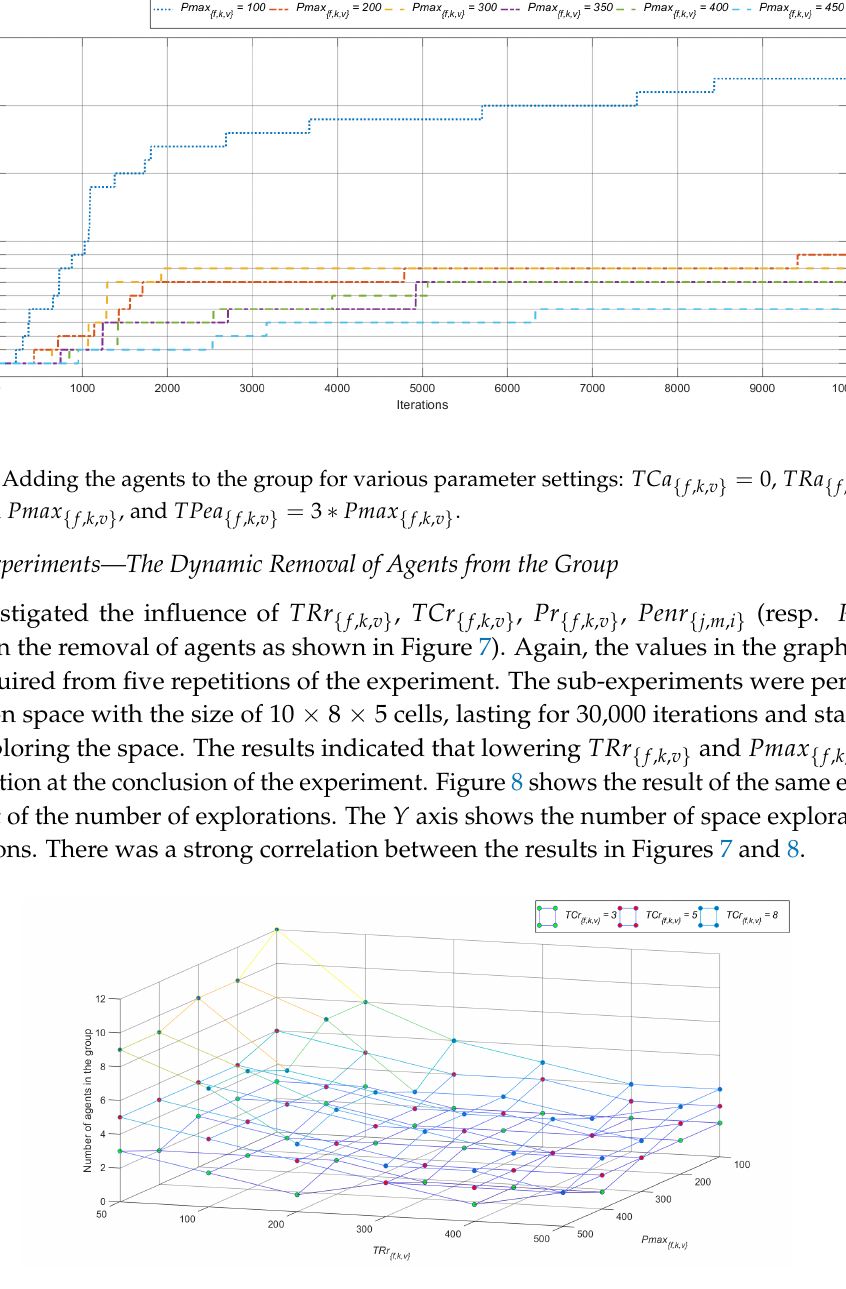
Figure 7. The number of the agents in the group after 30,000 iterations; we added 50 agents to the group in the 1000th iteration and removing agents was then turned